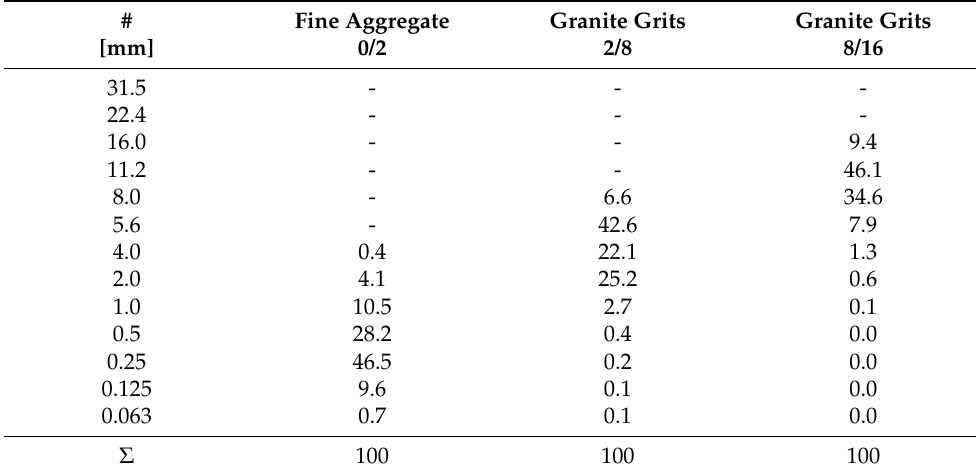
Table 3. Grain composition of aggregates.